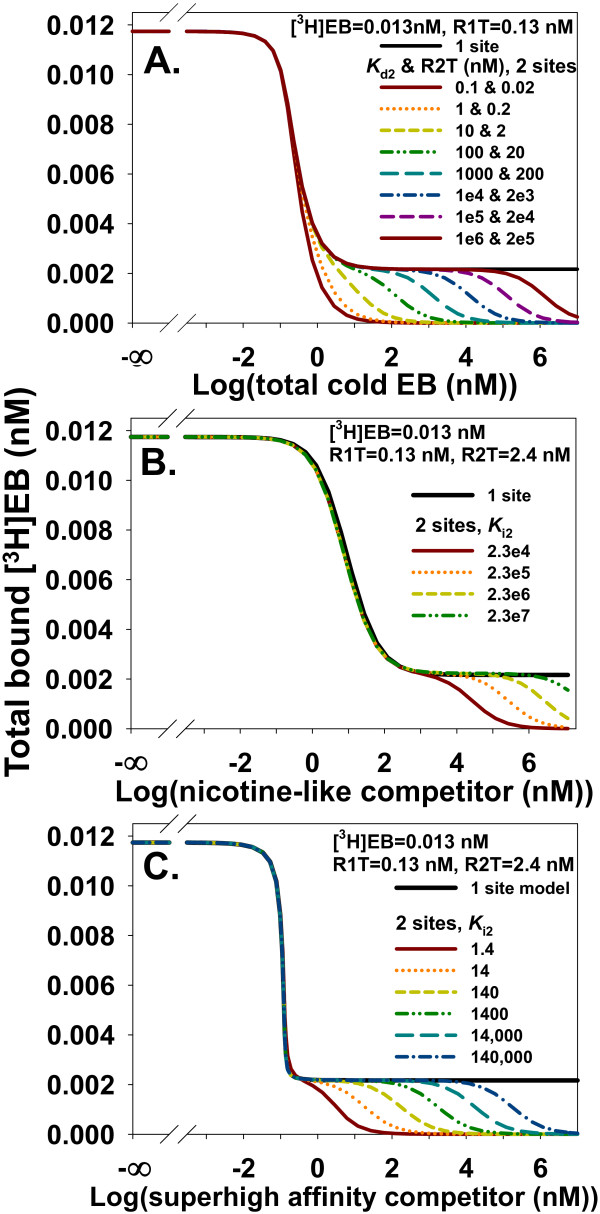
Binding to a low affinity second binding site with hypothetically large R2T and Kd2 or Ki2 values mimic NSB in homologous and heterologous competition data. A. The one site modelfree (α = 0.2) and two sites modelfree (α = 0) generated homologous competition data with Kd2 = R2T/0.2. With increasing R2T and Kd2, the two sites modelfree produces increasingly long plateaus of total bound [3H]EB, similar to NSB. Low-affinity specific binding is distinguished from NSB only when cold EB concentration exceeds Kd2. B. Heterologous competition of [3H]EB with a nicotine-like competitor at a low affinity site can mimic NSB. The one site modelfree with α = 0.2 generated heterologous competition data with Ki1 = 0.84 nM for the competitor (value for nicotine [18]). With these values and R2T = 2.4 nM and α = 0, the two sites modeltotal fits these data well up to a competitor concentration of Ki2. Low-affinity specific binding is distinguished from NSB only when the competitor concentration exceeds Ki2. C. With a superhigh affinity competitor, increasing R2T and varying Ki2 with heterologous competition of [3H]EB at a low affinity site can mimic NSB. The one site modelfree with α = 0.2 generated heterologous competition data with Ki1 = 1.3 × 10-4 nM. With α = 0, the two sites modeltotal fits well to these data up to a competitor concentration of Ki2. Low-affinity specific binding is distinguished from NSB only when competitor concentration exceeds Ki2.